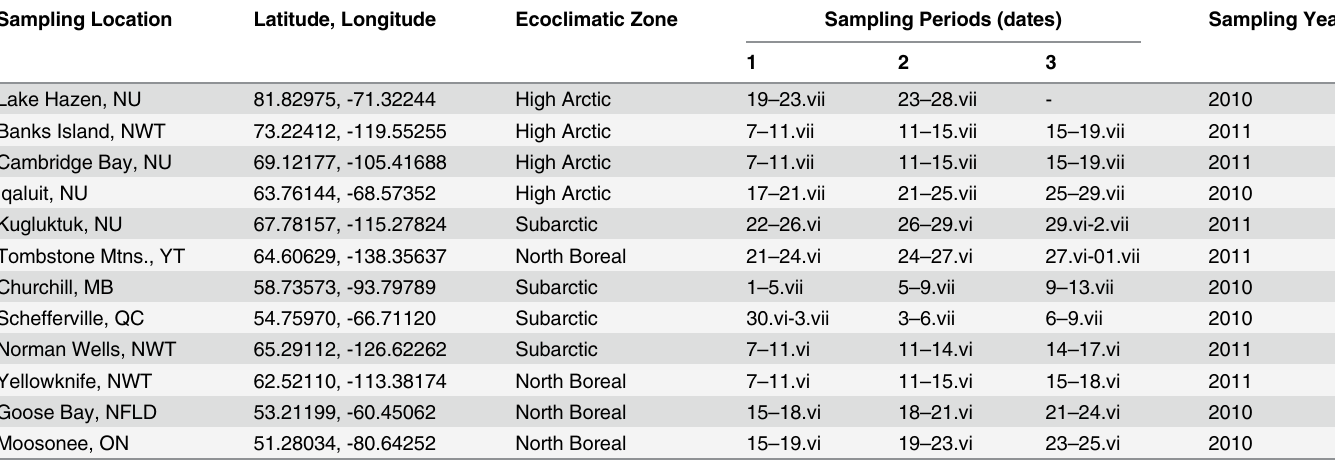
Table 1. Names, coordinates, and ecoclimatic zones of sampling locations, and dates of sampling. Sampling